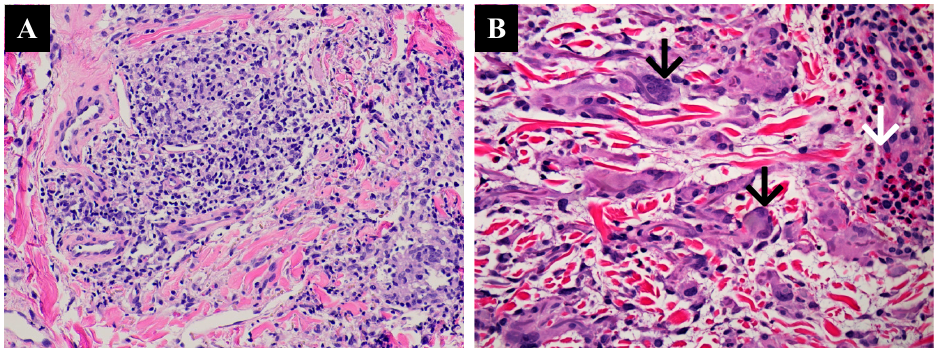
Figure 2. ( A ) A sarcoidal granuloma with severe perivascular inflammation (H&E, 20 × ). ( B ) A skin biopsy shows multinucleated giant cells (black arrows) with eosinophilic infiltrate (white arrow). In the control group, we found eighteen biopsies were necrobiotic GA (50%), fourteen were interstitial GA (39%), three were mixed GA (8%), and one was sarcoidal GA (3%). All of the controls showed some degree of perivascular inflammatory infiltrate (mild